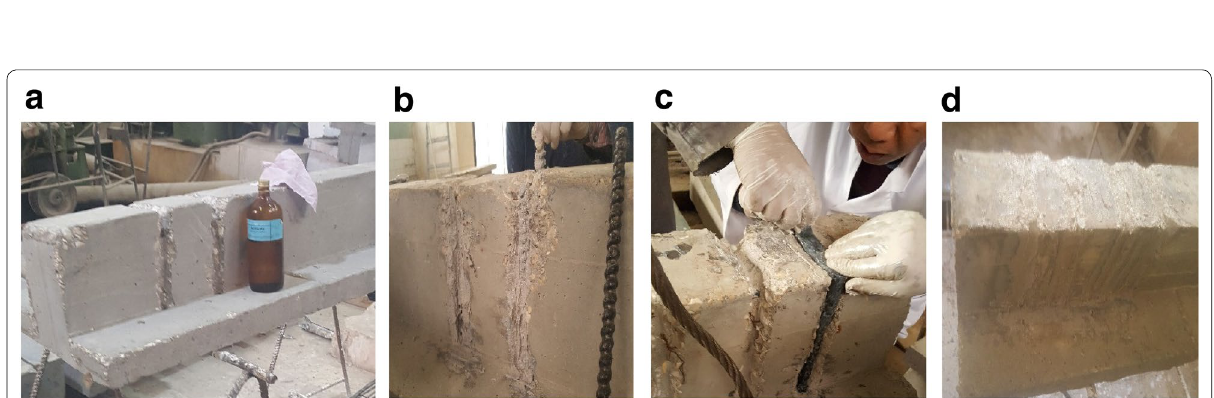
Fig. 6 Strengthening process of the T-beam: a cutting grooves and cleaning them with acetone; b filling half of the grooves with epoxy paste and inserting the BFRP bars; c inserting U-shaped or closed stirrups; and d filling the grooves with epoxy